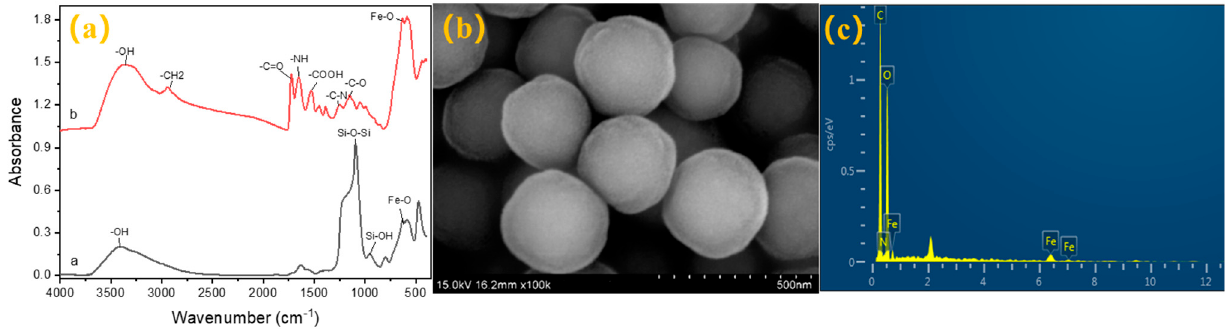
Figure 2. ( a ) FTIR spectra of Fe 3 O 4 @SiO 2 and Fe 3 O 4 @COOH; ( b ) SEM photo of Fe 3 O 4 @COOH; ( c ) EDS of Fe 3 O 4